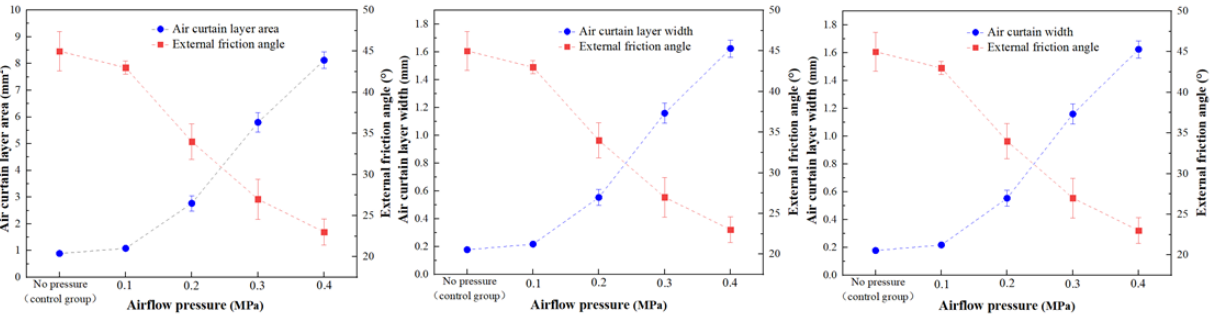
Figure 8. The external friction angle against the soil-surface roughness as well as the width and area of the air curtain layer.